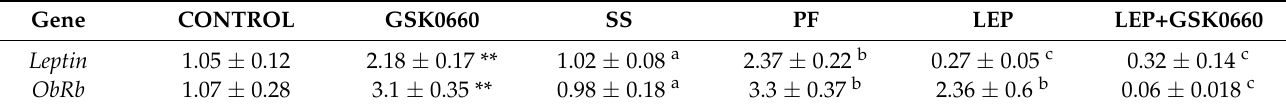
Results are represented by mean ± SEM (n = 6) per group of animals. Data from real-time RT-PCR are expressed relative to 18S rRNA and the mRNA levels are expressed relative to the Control group and SS group the level of which were set at 1.0 arbitrarily